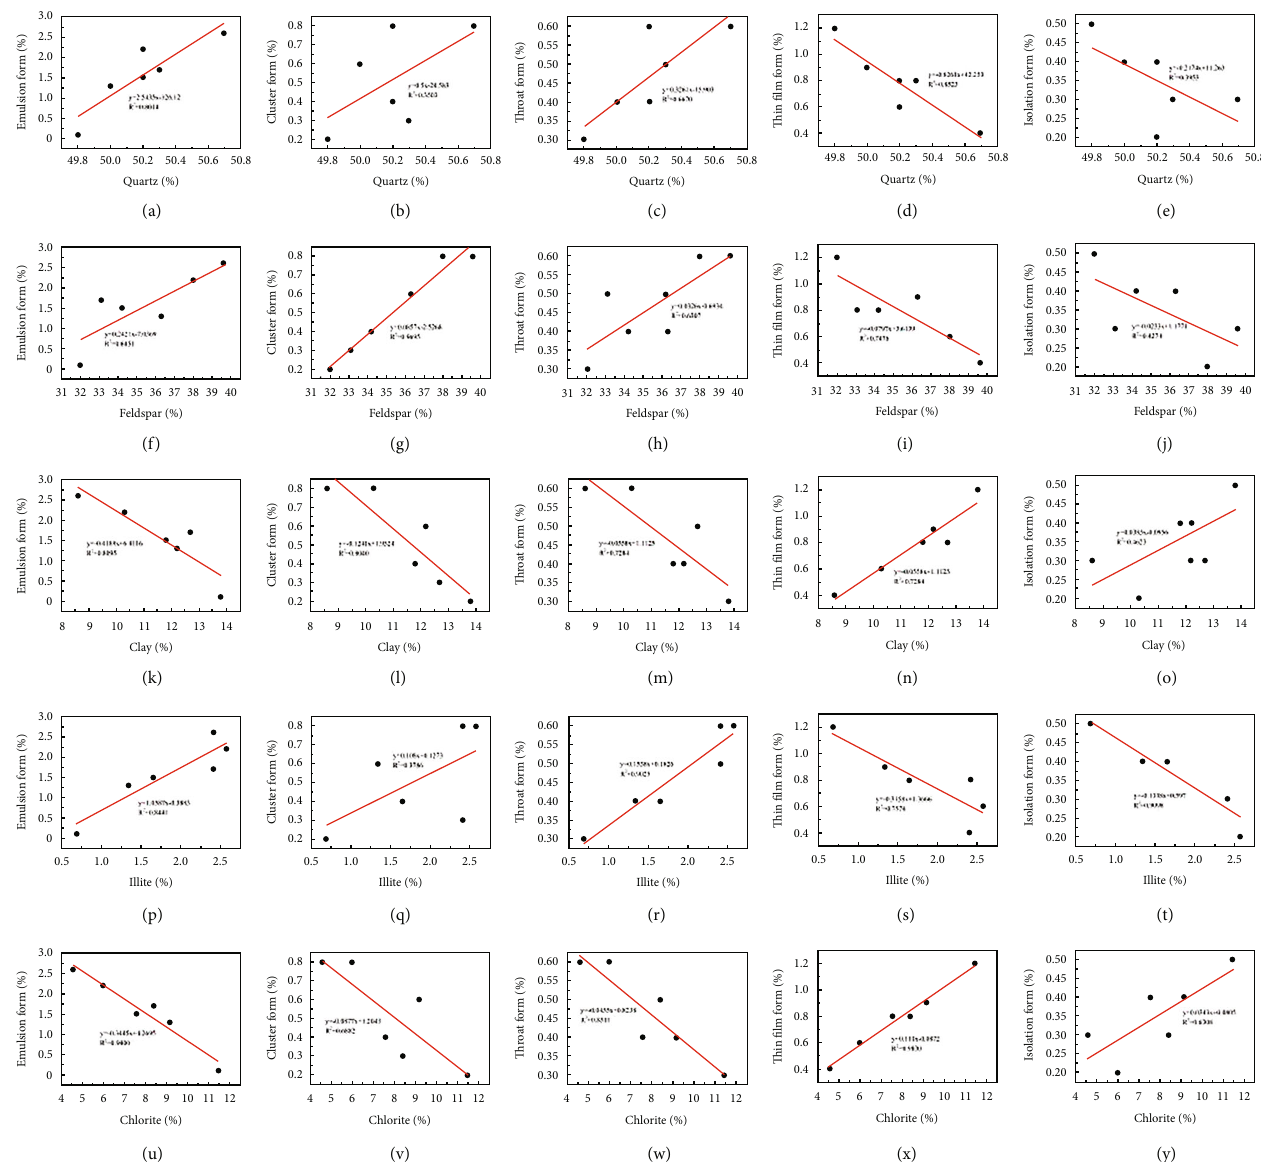
Figure 10: The relationship between adsorption tight oil types and minerals. (a – e) Quartz; (f – j) feldspar; (k – o) clay; (p – t) illite; (u – y)